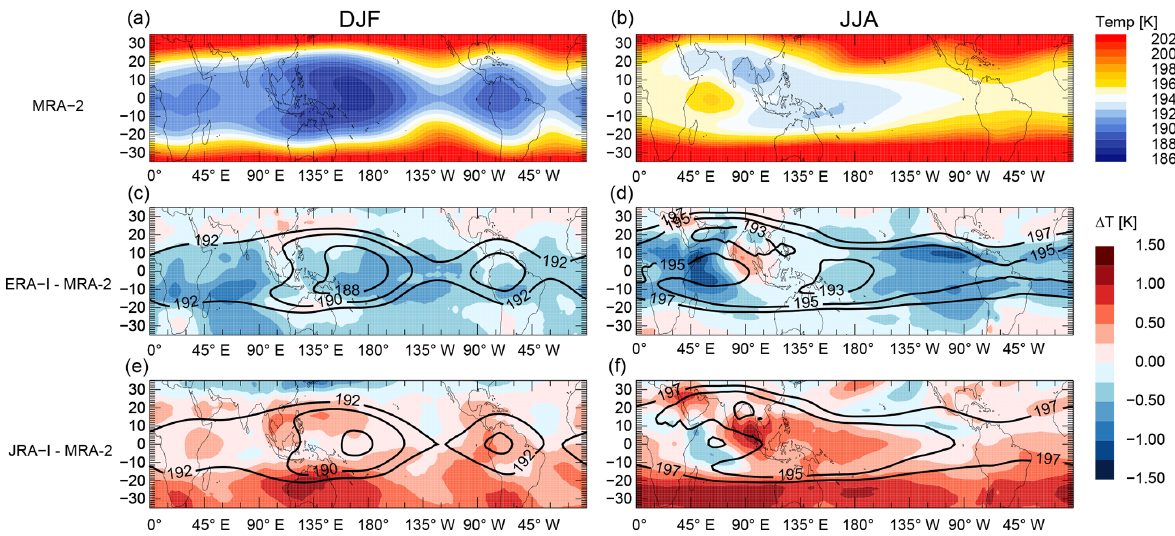
Figure 5. Climatological mean cold point tropopause temperatures during boreal winter (DJF, a , c , e ) and boreal summer (JJA, b , d , f ) from MERRA-2 (a, b) , along with differences in ERA-I (c, d) and JRA-55 (e, f) relative to MERRA-2. Isolines in the middle and lower rows show absolute values of tropopause temperature. Cold point tropopause temperatures are defined here as minimum temperatures between θ = 360K and θ =